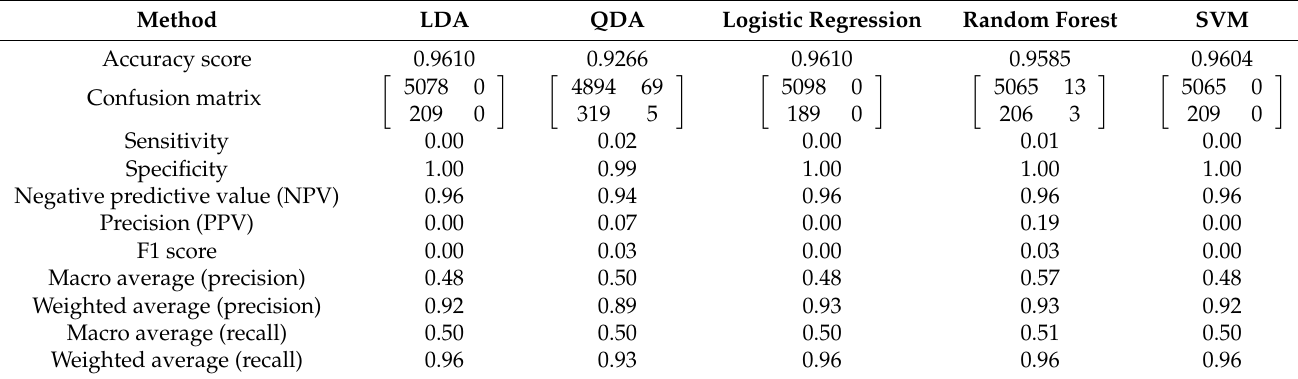
Table 1. Results for models created on an imbalanced sample (test